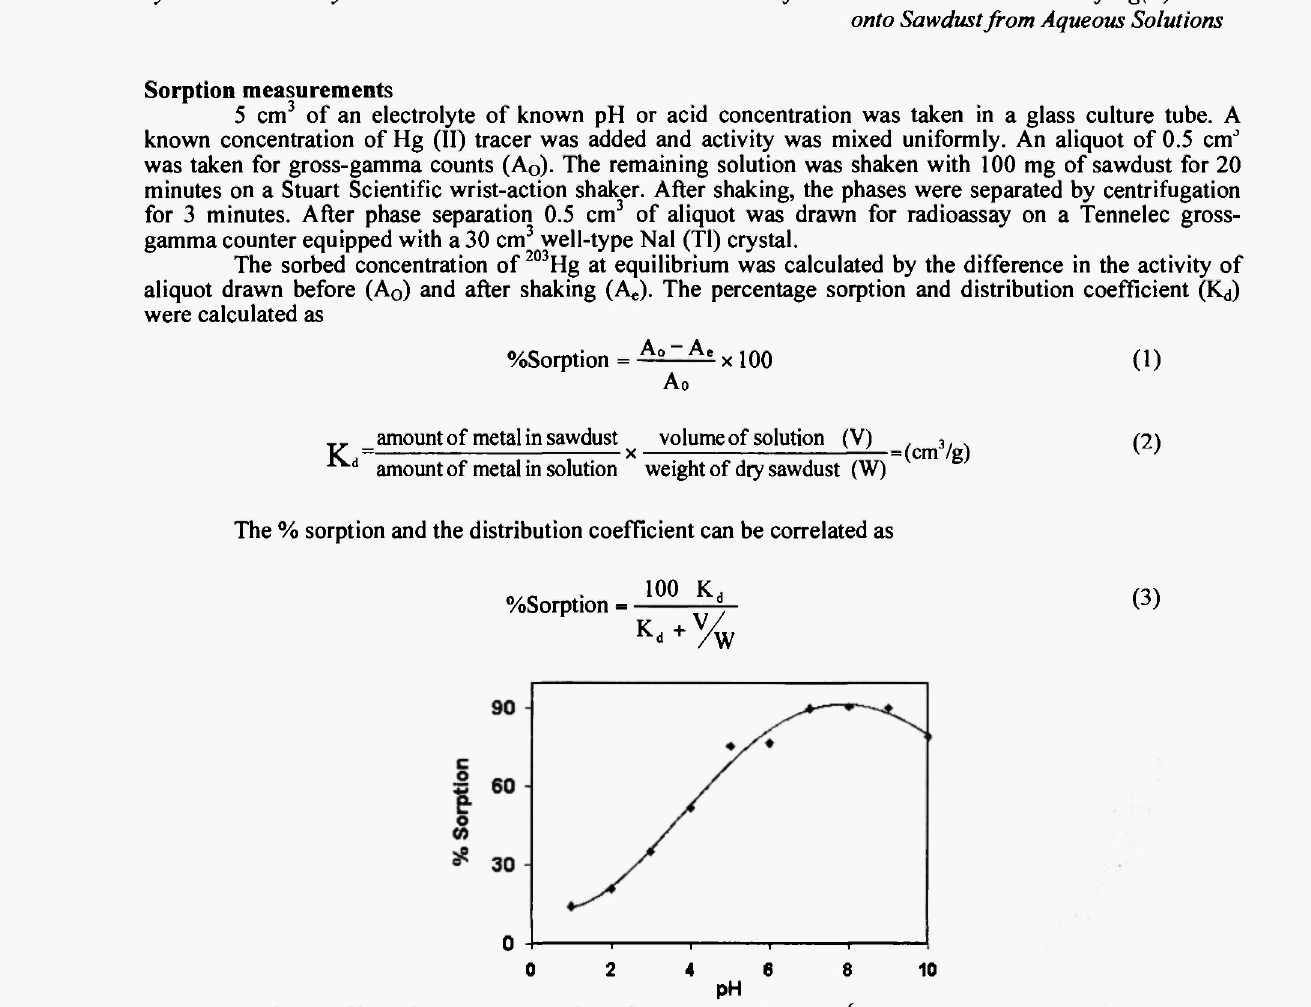
Fig. 1. Effect of pH on the sorption of Hg(II) ions (7.39x1ο -6 Μ) onto sawdust (100